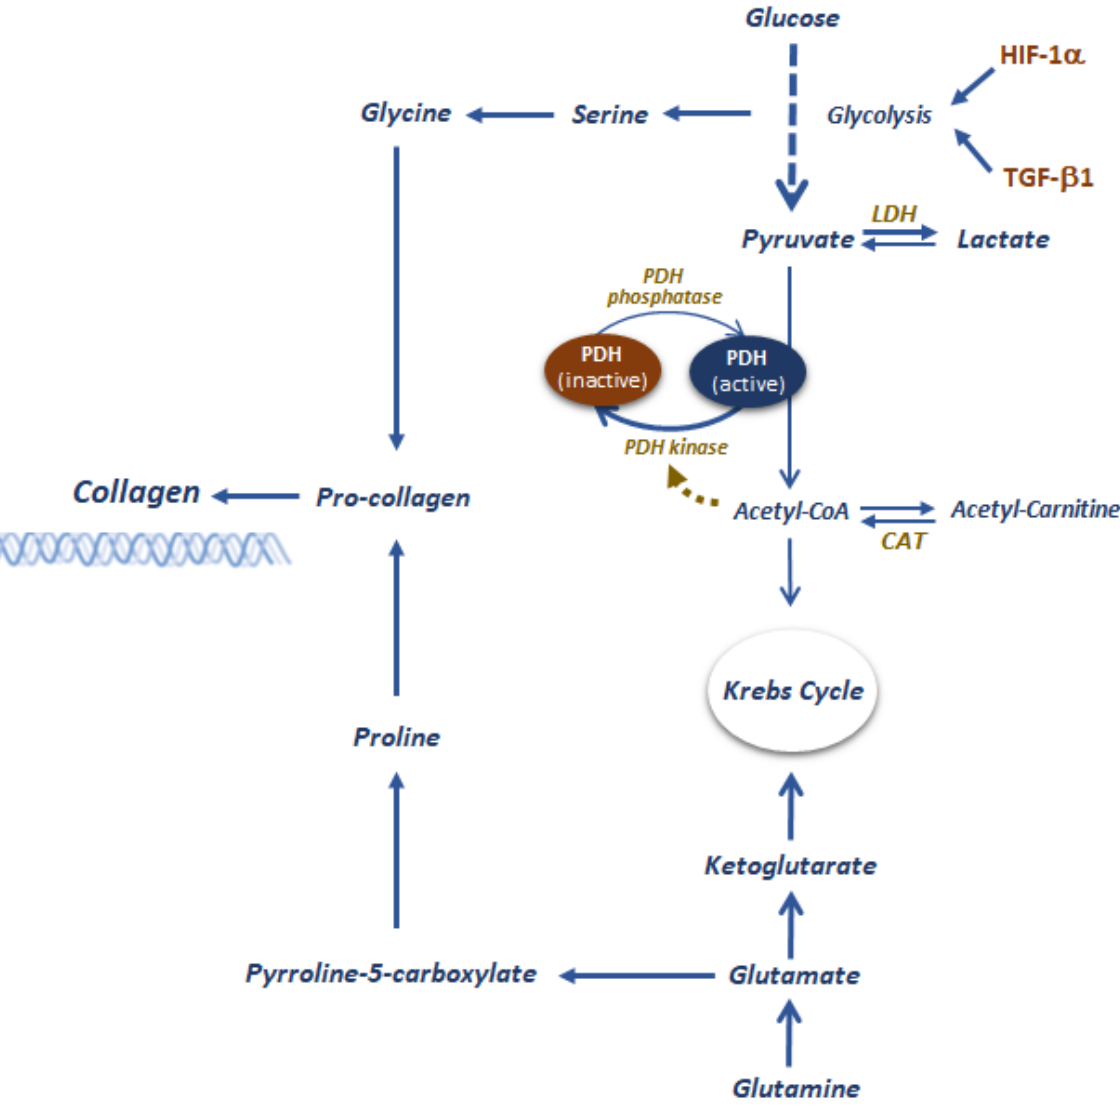
Figure 1. Graphical representation of metabolic control of fibrosis. Several metabolic processes such as glycolysis, glutaminolysis, and fatty acid oxidation contribute to the deposition and other ECM components. High glucose levels activate glycolysis directly by increasing HIF-1a expression, which in turn amplifies the production of TGF-b1. The latter would not only further sustain high glycolytic rates but also fibrogenesis. The increased production of lactate sustains macrophages polarization toward an inflammatory phenotype, which worsens the fibrosis. In addition, the increased glycolytic rate makes glycolytic intermediates available in larger quantities, contributing to the synthesis of amino acid substrates for collagen synthesis. Moreover, glutamine has a role in collagen synthesis, but it can also contribute to ATP production through oxidative phosphorylation. A key metabolic switch in maintaining a chronically activated fibrogenic state is the pyruvate dehydrogenase complex